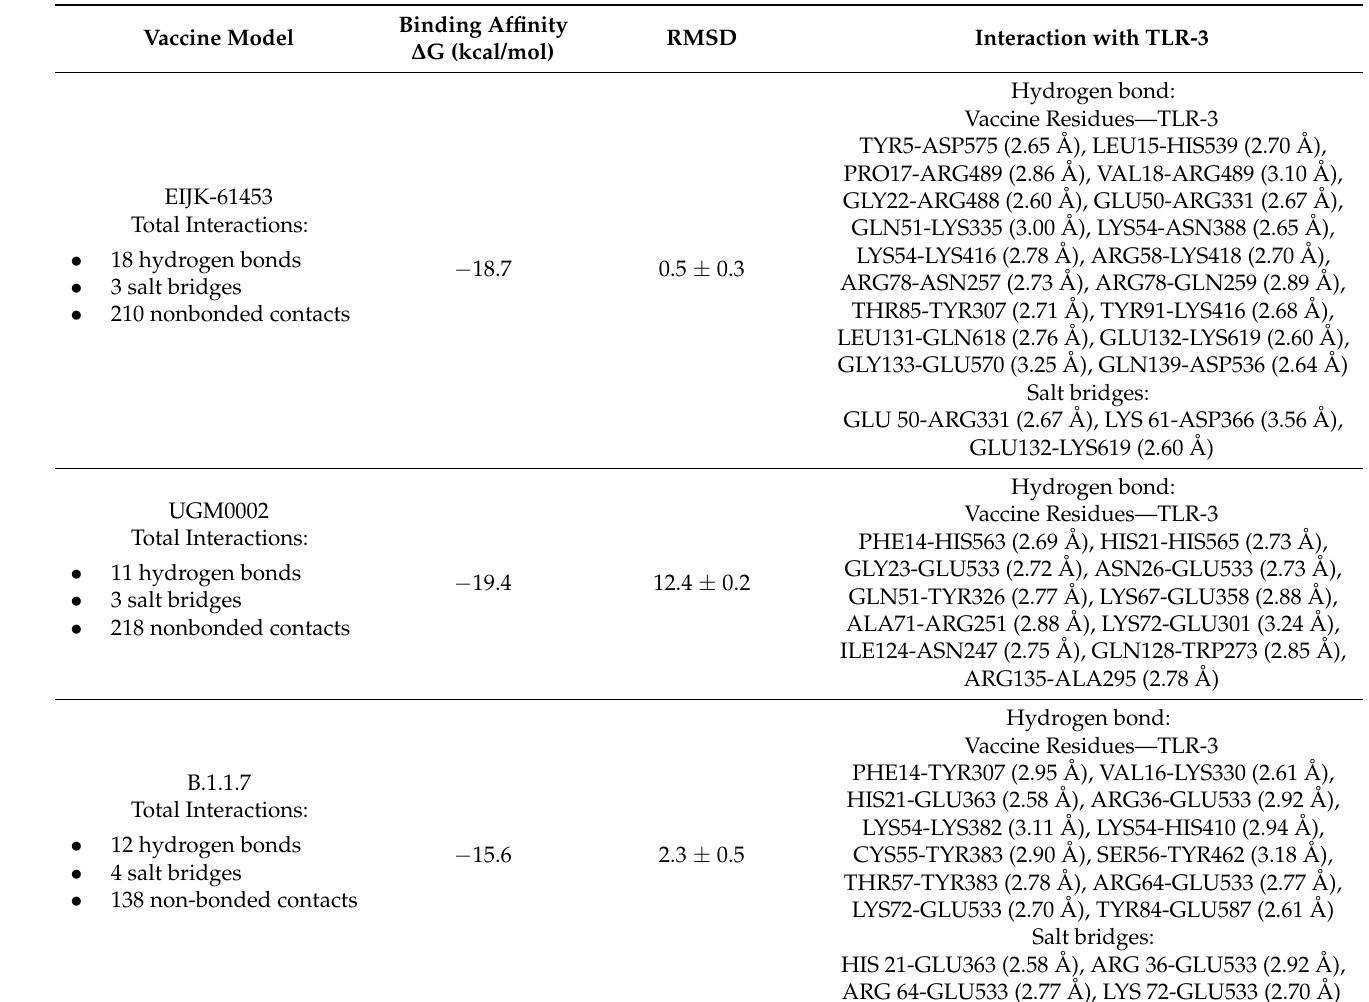
Figure 4. Docking of proteins between TLR-3 and ( a ) Wuhan-Hu-1 and EIJK-61453, ( b ) UGM0002 ( c ) B.1.1.7. ( c ) B.1.1.7. Table 7. The bond type and amino acid residues interacting between vaccine models and